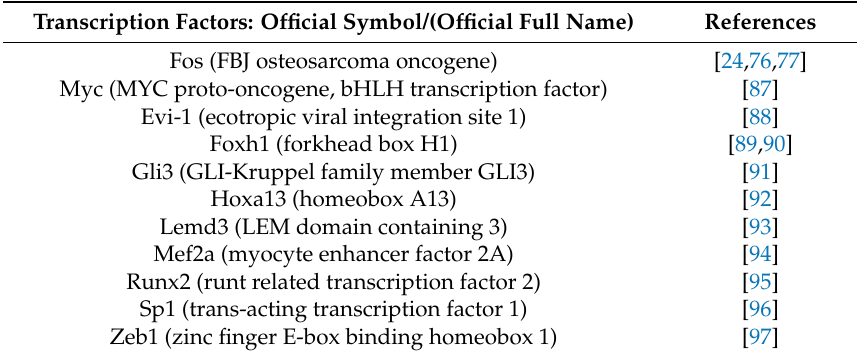
Table 1. Smad2 Nuclear Interacting Transcription Factors.